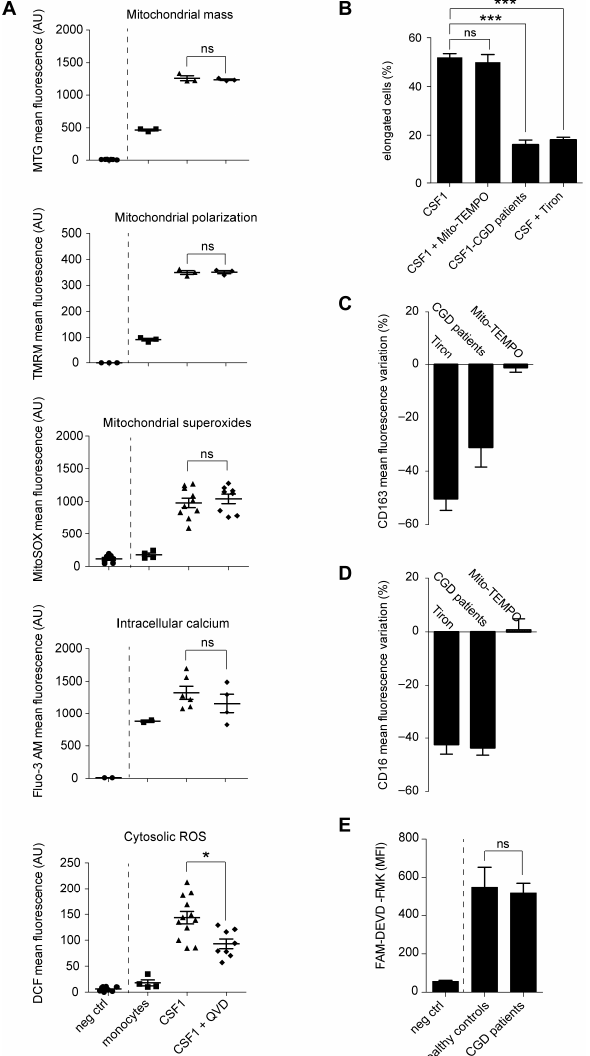
Figure 4. NOX2-dependent cytosolic ROS production, downstream of caspase activation. ( A ) Monocytes were untreated or treated with CSF-1 (100 ng/mL, 4 days) in the absence or presence of 50 µ M Q-VD-OPh before measuring mitochondrial mass with MTG (MitoTracker Green), mitochondrial membrane potential with TMRM (tetramethylrhodamine), mitochondrial superoxides with MitoSOX, intracellular calcium with Fluo-3 AM and cytosolic ROS with DCF (2’,7’-dichlorofluorescein). The negative control (neg ctrl) corresponded to the absence of cell incubation with MTG, TMRM, MitoSOX, Fluo-3 AM or DCF. (*, p < 0.05; ns, non-significant; Kruskal–Wallis test with Dunn’s post test). ( B – D ) Monocytes from healthy donors were treated with CSF-1 (100 ng/mL, 4 days) in the absence or presence of Tiron (500 µ M), or Mito-TEMPO (50 nM), and monocytes from patients with a chronic granulomatous disease (CGD, n = 3) were treated with CSF-1 (100 ng/mL, 4 days). ( B ) The fraction of cells with an elongated shape (elongation factor > 2.5) was measured. (***, p < 0.001/6; ns, non-significant; Fisher test with Bonferroni correction). Mean ± SE. ( C , D ) Variation in the Mean fluo- rescence index of cell surface CD163 and CD16 expression in healthy donor monocytes treated with CSF-1 (100 ng/mL, 4 days) and Tiron ( n = 7) or Mito-TEMPO ( n = 7) and in CGD monocytes treated with CSF1 alone ( n = 3), all compared to CSF1-treated healthy monocytes (Mean ± SE). ( E ) DEVD activity in CSF-1-treated healthy donor and CGD monocytes (Mean ± SE of three measurements; Mann–Whitney test; ns,